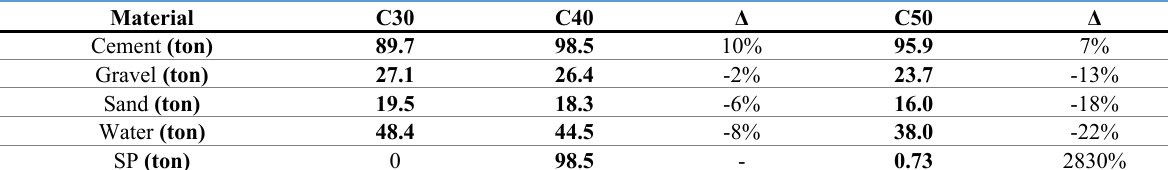
Table 7. Total of materials consumed in the concrete used in the